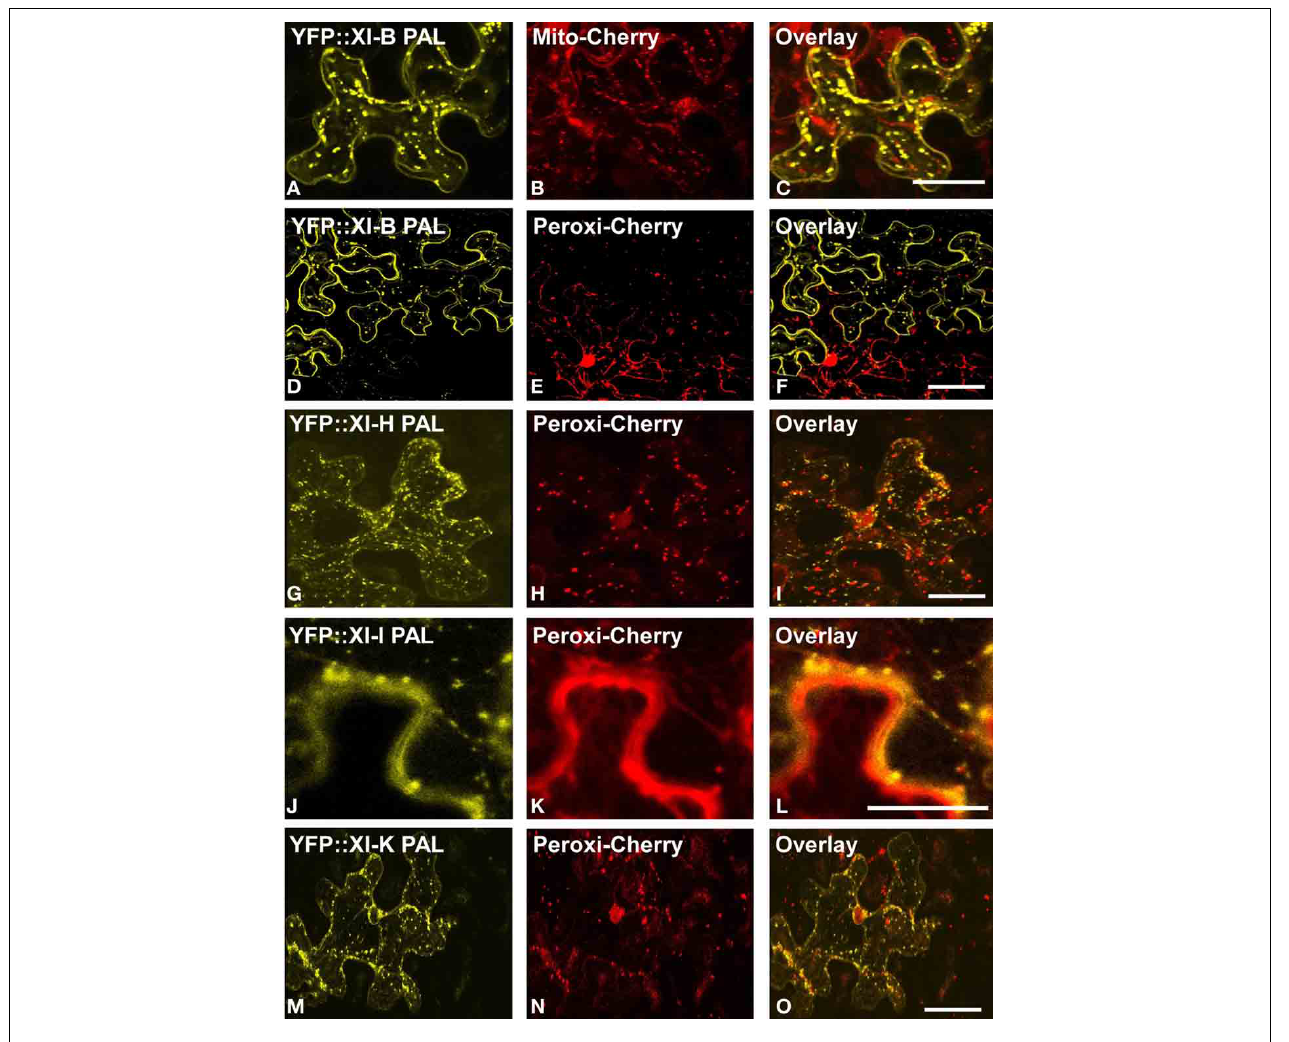
FIGURE 5 | Lack of co-localization with mitochondrial and peroxisome markers. Co-expression of YFP::Myosin XI PAL sub-domains with mCherry markers for mitochondria and peroxisomes in epidermal leaf cells of N.